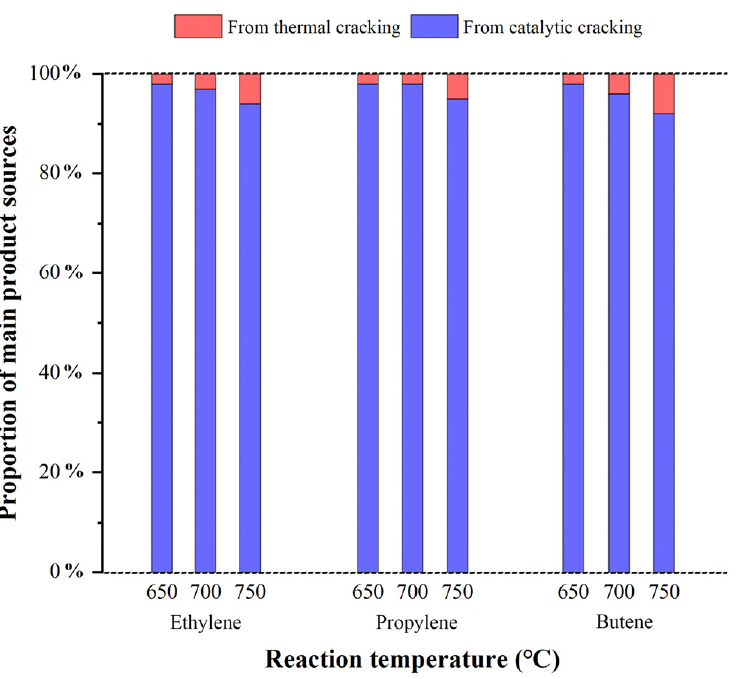
Figure 8. The proportion of the main products derived from catalytic cracking and thermal cracking for pentene cracking over H-ZSM-5 at 650–750 °C. Reaction conditions: total pressure, 130 kPa; partial pressure, 60 kPa; WHSV, 83 h − 1 .